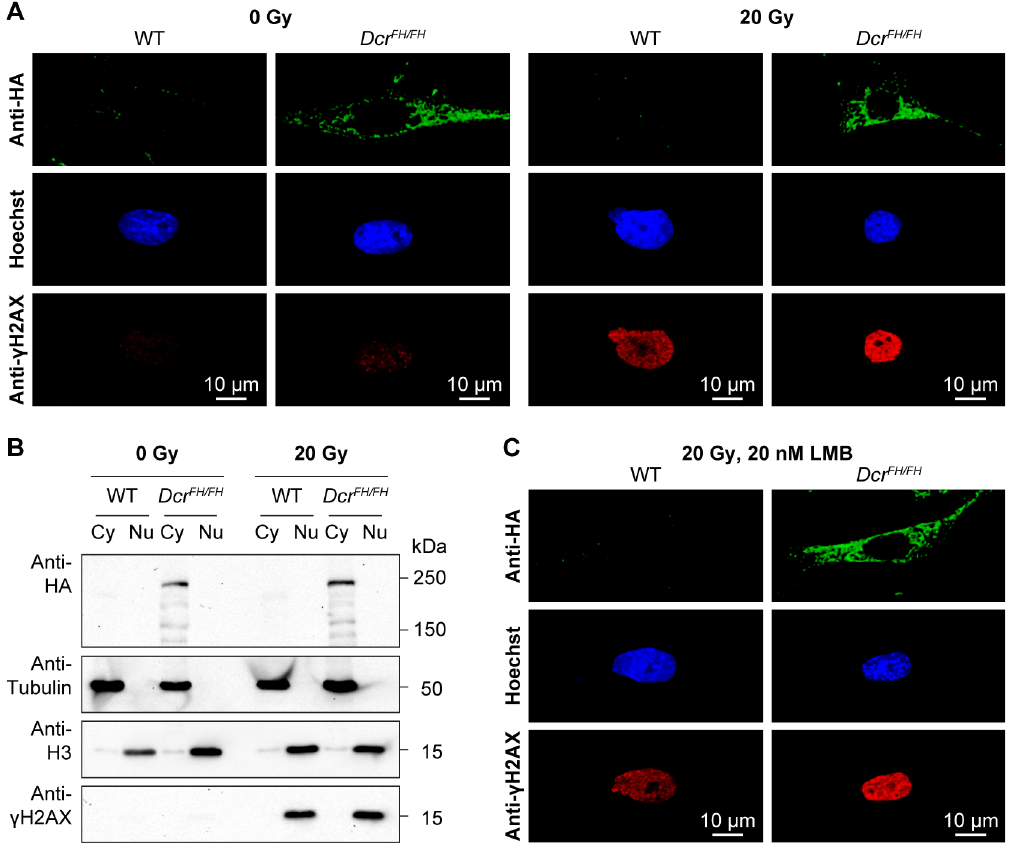
Fig 4. Dicer does not translocate to the nucleus after DNA damage. (A) Confocal imaging of anti-HA stained wild type and Dcr FH/FH PMEFs after irradiation. Cells were irradiated with 20 Gy and then allowed to recover for 30 min. Activation of the DNA damage response was verified with anti- γ H2AX staining. Nuclei are stained with Hoechst. Scale bars represent 10 μ m. (B) Western blot analysis after irradiation and subcellular fractionation. Anti- HA antibody was used on cytoplasmic (Cy) and nuclear (Nu) extracts of irradiated and non-irradiated cells. Tubulin served as a cytoplasmic marker, histone H3 as a nuclear marker and γ H2AX as a marker of DNA damage. (C) Confocal microscopy on anti-HA stained wild type and Dcr FH/FH PMEFs after irradiation and LMB